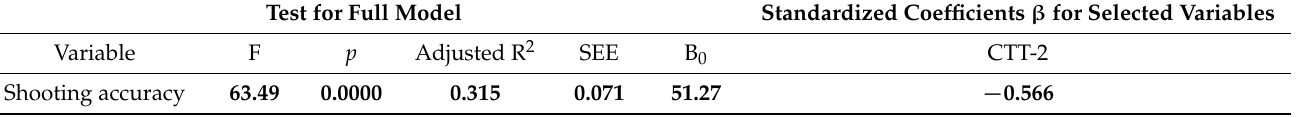
Test for Full Model Standardized Coefficients β for Selected